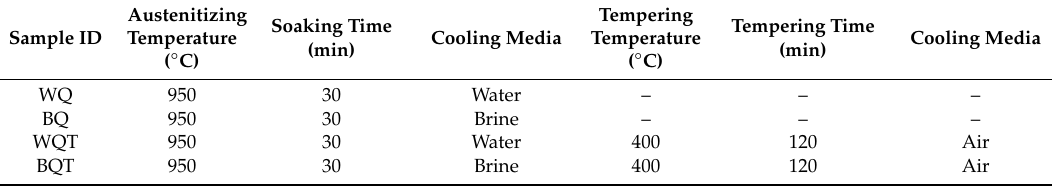
Table 2. Parameters of quench hardening and tempering processes applied to low-carbon